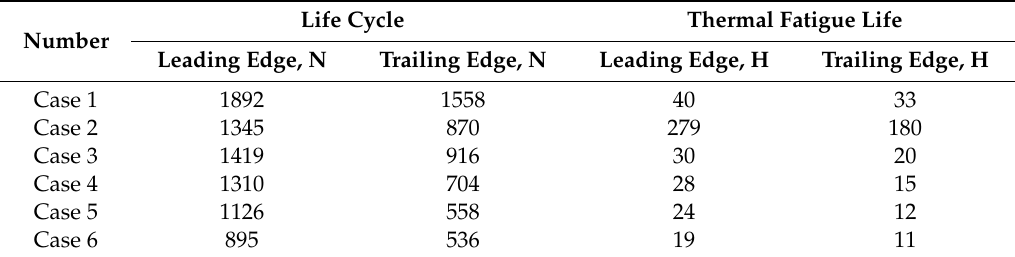
Table 7. Thermal fatigue life of the TBC on the